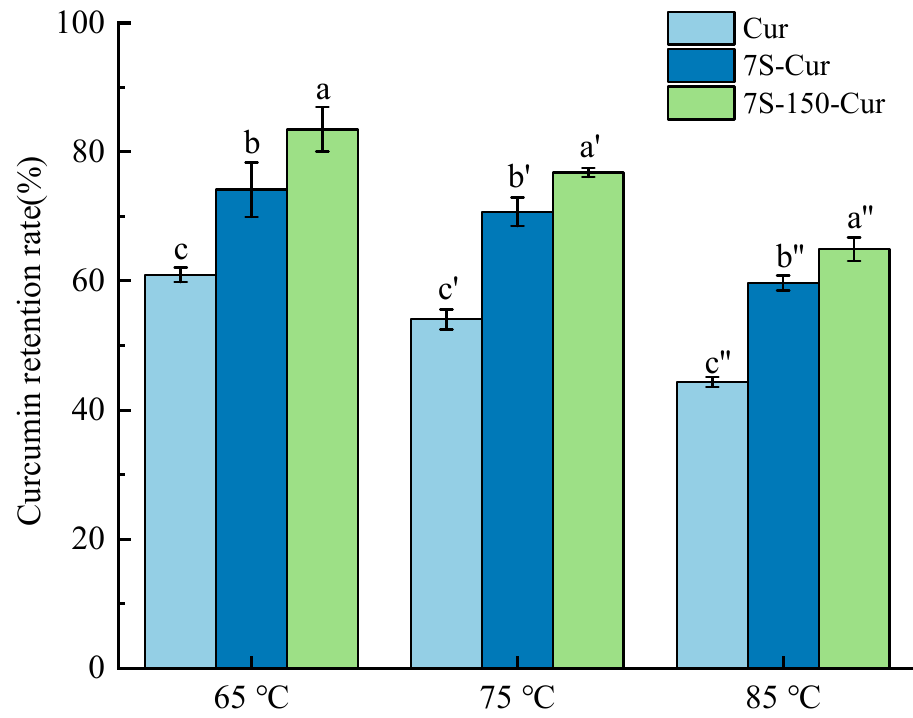
Figure 6. Heat stability of the free curcumin, 7S-Cur, and 7S-150-Cur nanocomplexes (different superscript (a,b), (a ′ ,b ′ ), and (a ″ ,b ″ ) letters in the figure indicate the significant differences between samples at the same heating temperature ( p < 0.05), respectively). 7S: soy β -conglycinin; 150: dextran (150 kDa); Cur: curcumin.